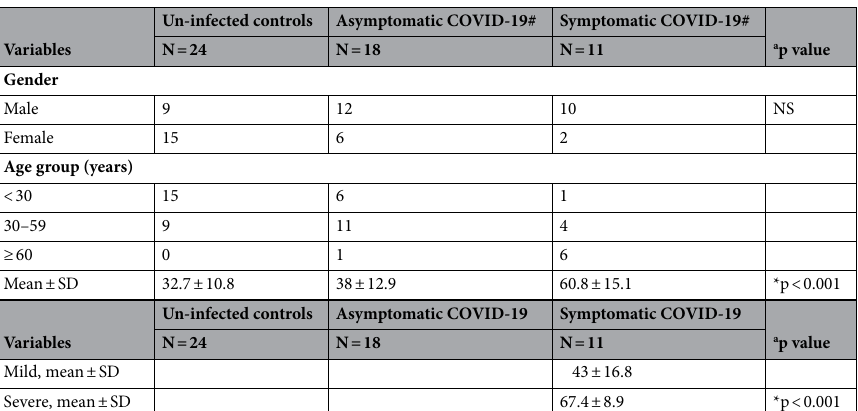
Table 1. Description of study population. a p value as compared across age groups between Controls, Asymptomatic and Symptomatic COVID-19 cases. ‘#’, all COVID-19 cases had a respiratory sample which was positive for SARS-CoV-2 by PCR within a 48 h prior to collection of blood samples; ‘*’, significantly different; NS, not statistically significant; the Kruskal–wallis test was conducted to determine non-parametric statistical comparison between